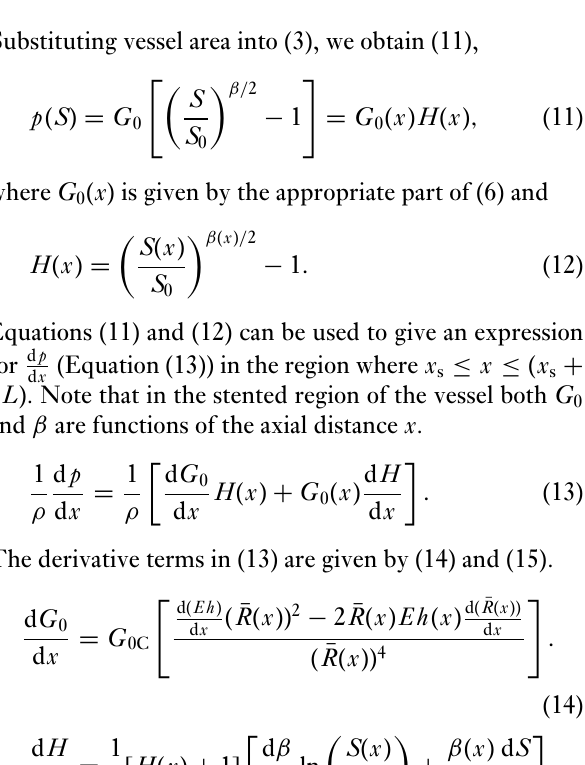
where p is the inlet pressure and t f is the period of the i curve (0.25 s in this case). The stent was assumed to have a length L of 15 mm with an expanded radius R The unstressed vessel radii for all segments of the network were also taken to be 1.5